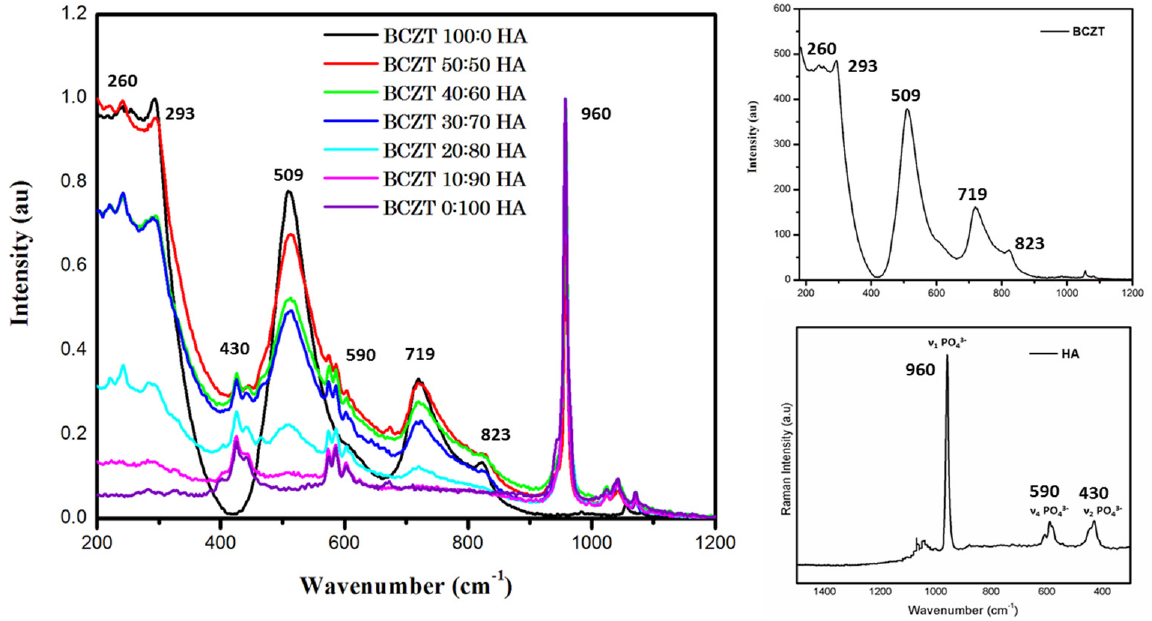
Figure 1: Raman spectroscopy of the HA-BCZT composites of different rations, the Raman spectra of the pristine BCZT and Hydroxyapatite with their active Raman modes Table 2: The comparison of the crystallinity and phase purity of hydroxyapatite, the shift in the various Raman Harmonic modes, and the EDX elemental composition for the different synthetic conditions using hydrothermal route